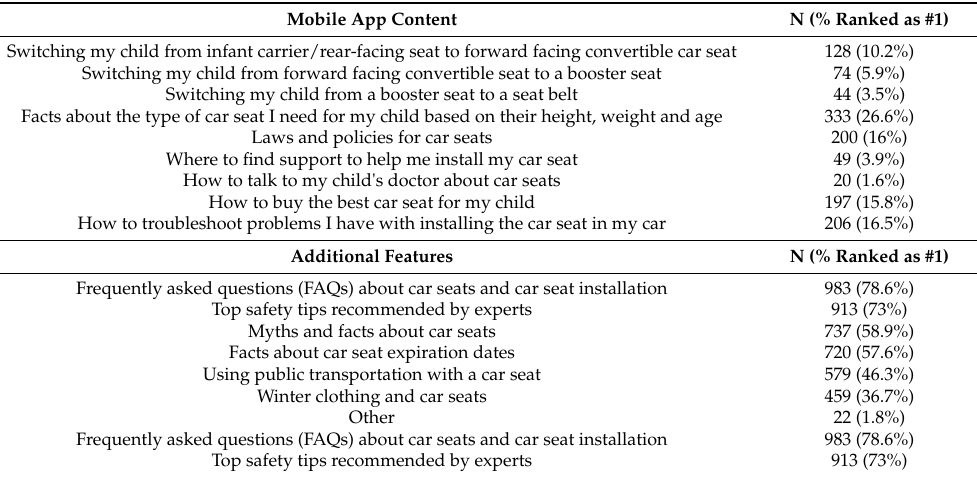
Table 3. Ranking of topics by national survey